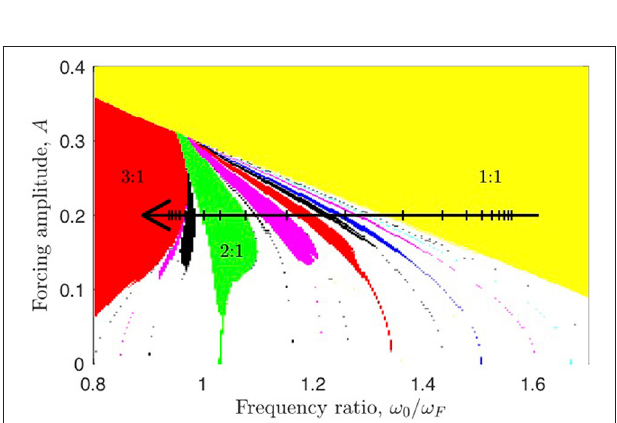
FIGURE 6 | Bifurcation diagram showing the stroboscopic map for the van der Pol oscillator (3) as a function of the ratio of the unforced internal frequency to the forcing frequency, ω 0 /ω F , obtained by varying parameter α with A = 0.2 and γ = 5 fixed. The colored regions corresponds to synchronization: 1:1 (yellow), 2:1 (green) and 3:1 (red). Regions with disconnected dots correspond to higher rational synchronization or quasiperiodic motions.